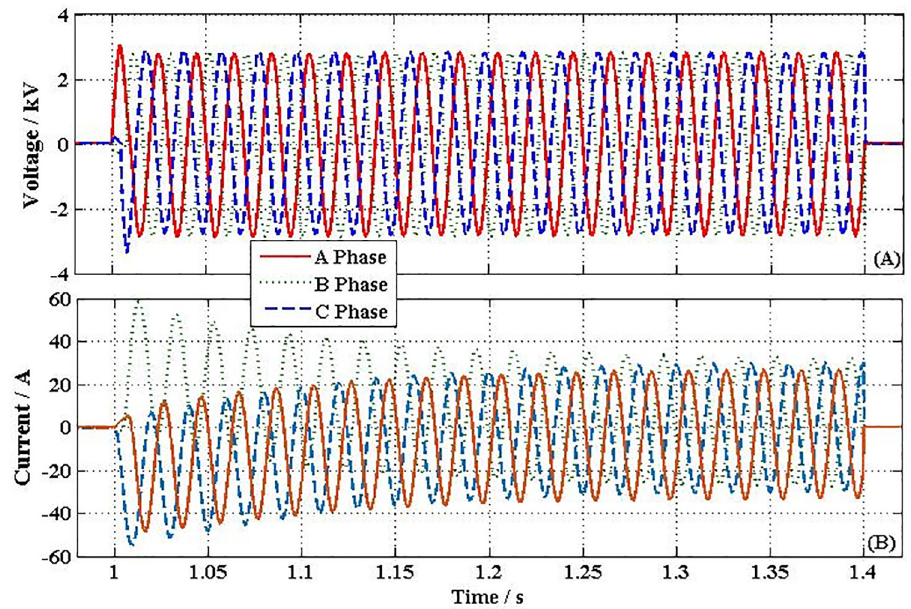
Fig 10. Transient performances curve of NFFCLs 1 . (A) Voltage of single series capacitance (B) Output current of H- bridge circuit.